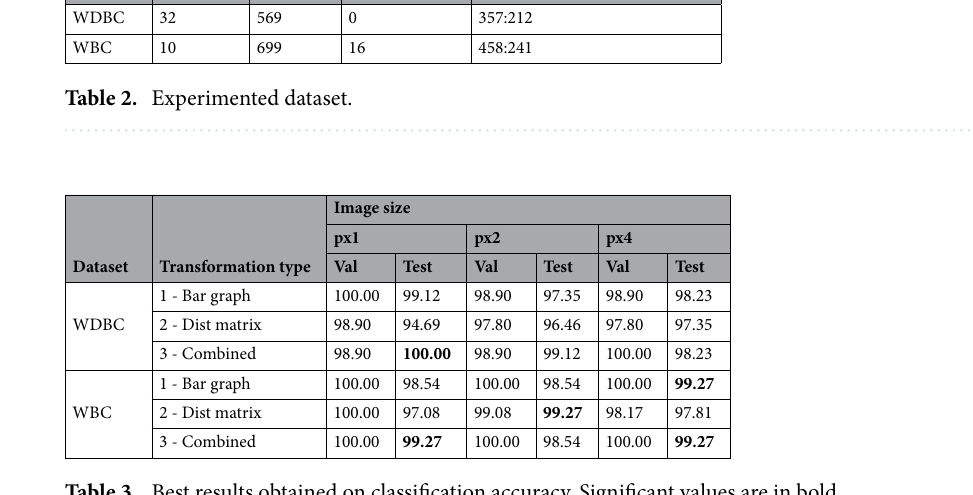
Table 3. Best results obtained on classification accuracy. Significant values are in bold.